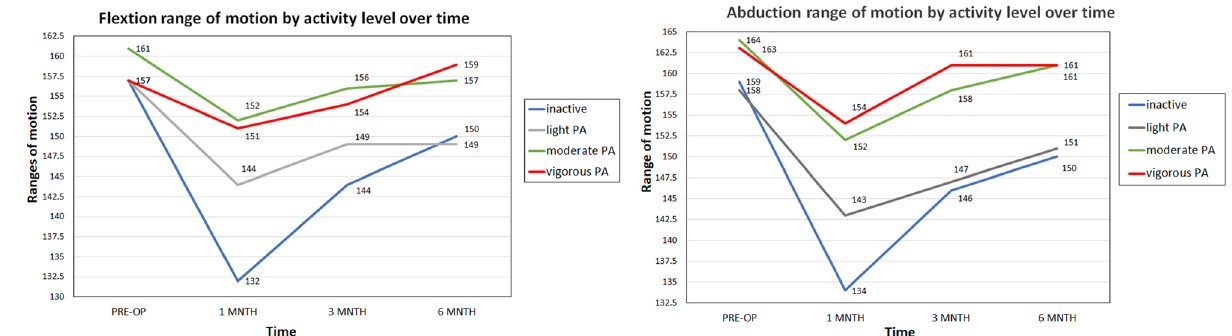
Figure 3. The effect of physical activity on abduction flexion range of motion by activity level over